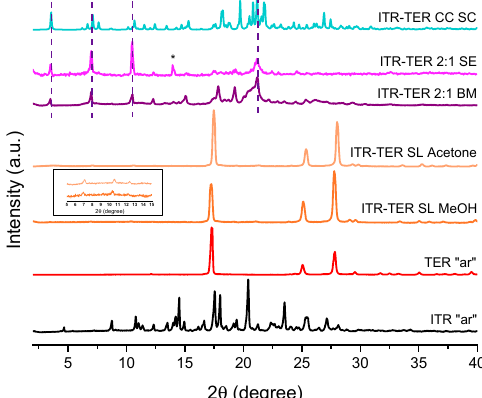
Figure 4. PXRD patterns of the ITR and TER starting material, as received powders (“ar”), samples Figure 4. produced by the slurry method from methanol (ITR–TER SL MeOH) and acetone (ITR–TER SL acetone), the ball milled sample containing ITR and TER in a 2:1 stoichiometric ratio (ITR–TER 2:1 BM), the sample obtained by the slow evaporation of ITR and TER in a 2:1 stoichiometric ratio from methanol (ITR–TER 2:1 SE) and a powder diffraction pattern of the ITR–TER cocrystal calculated from the single crystal X-ray data (ITR–TER CC SC). * Indicates the peak of ITR, broken lines indicate the position of key diffraction peaks of the cocrystal, while the insert shows the presence of the cocrystal peaks in the samples obtained by the slurry method.